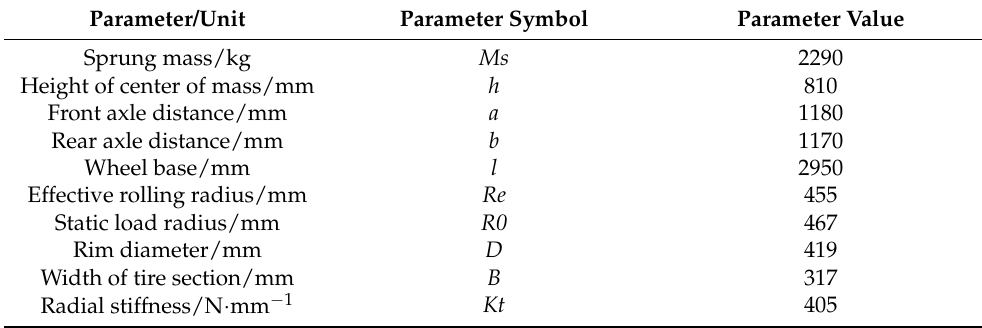
Table 3. Vehicle and tire